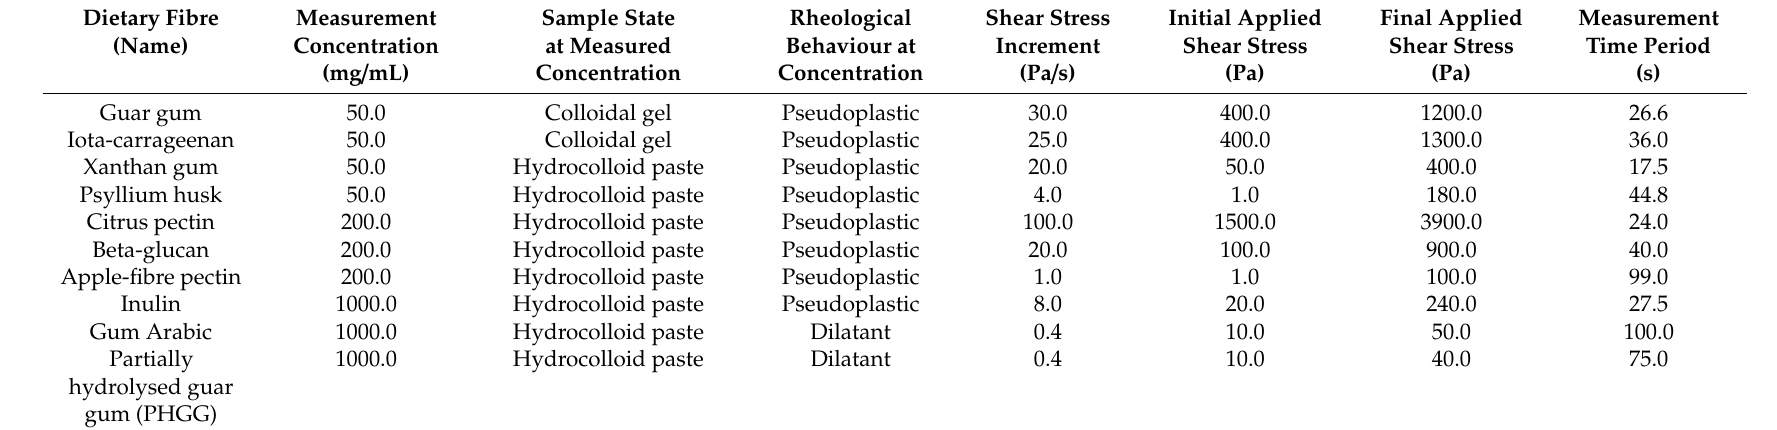
Table 2. Measured concentration, colloidal state, rheological behaviour and method analysis parameters under parallel plate